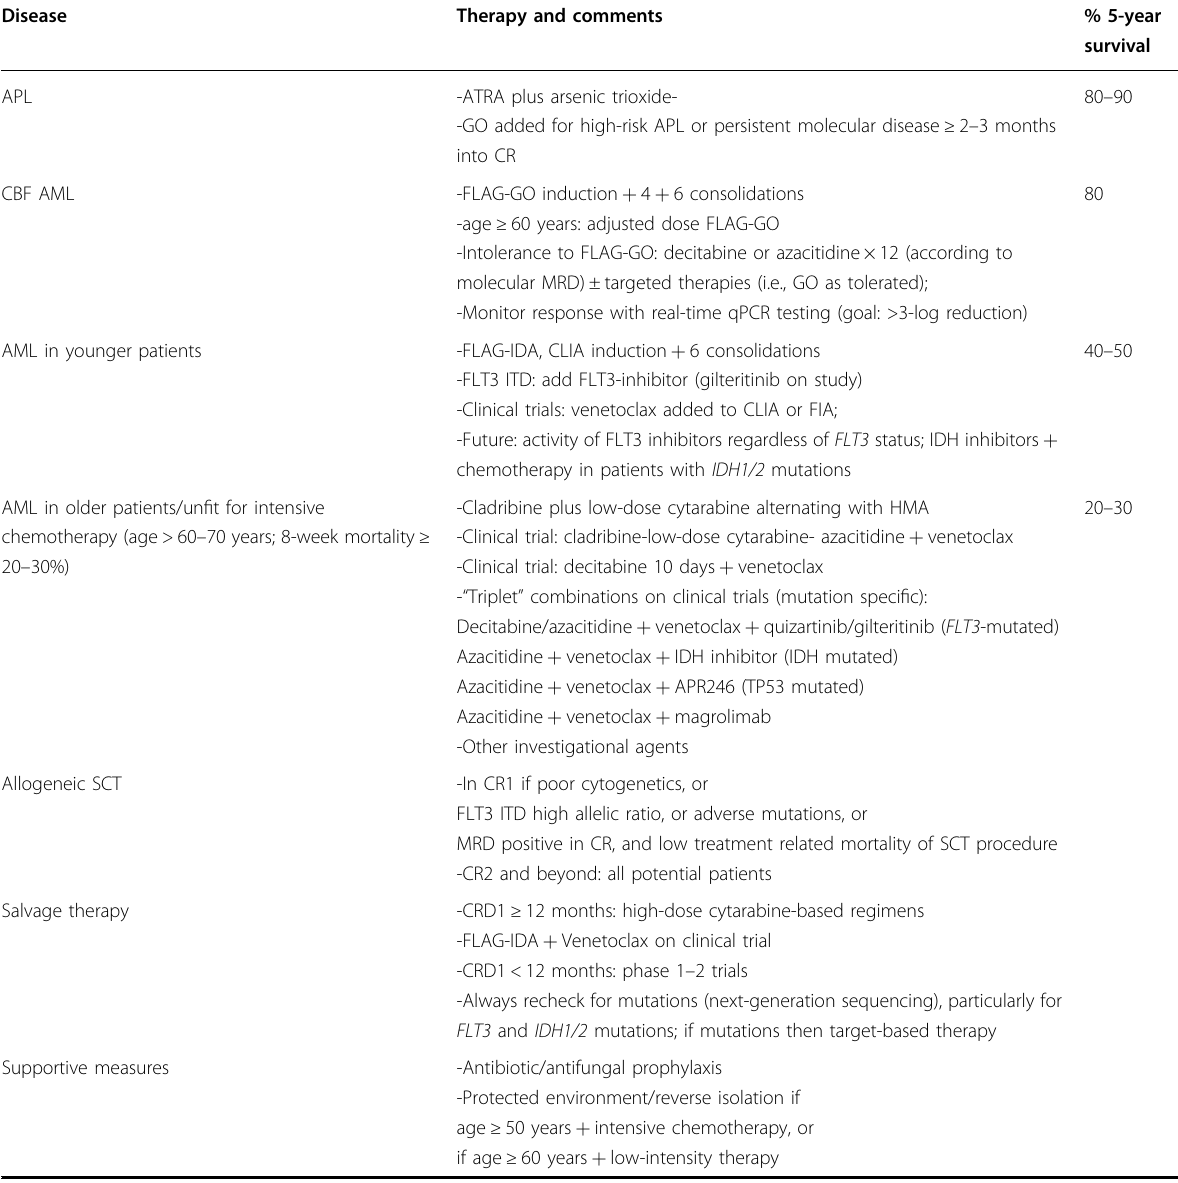
Table 4 General approach to patients with AML at MD Anderson in